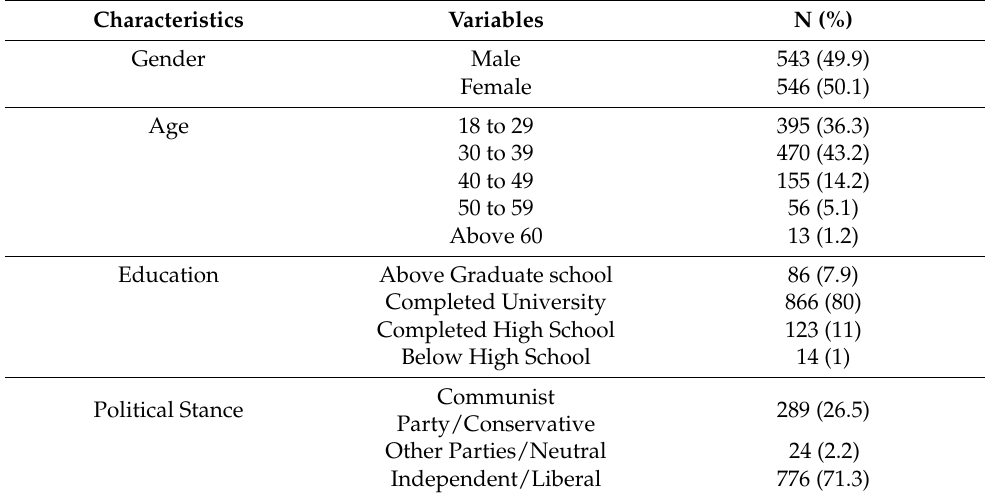
Table 1. Sample Descriptive Statistics (N =